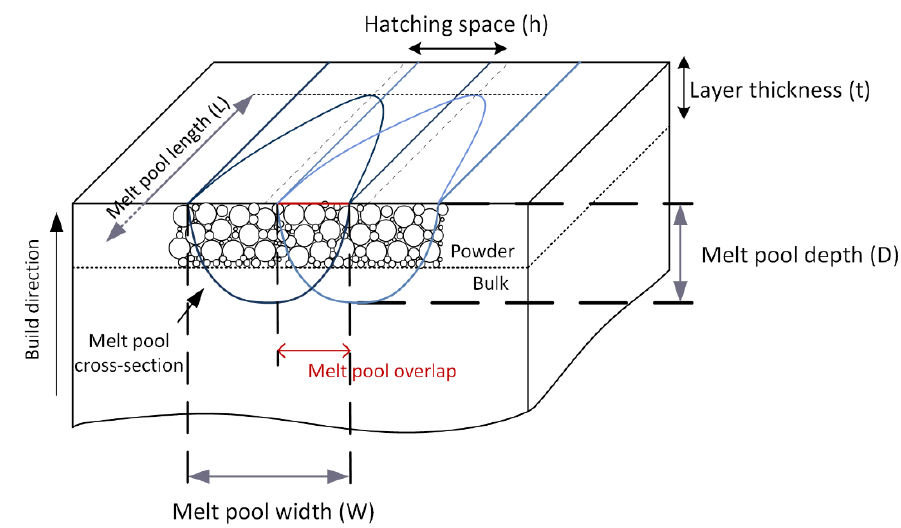
Figure 1. Schematic representation of the melt pool and the corresponding geometric characteristics [18].